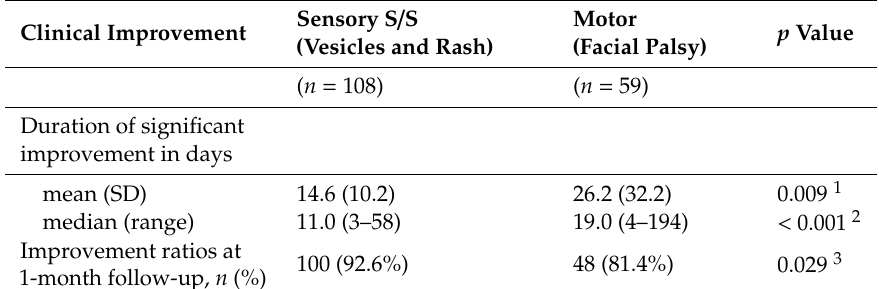
Table 4. Outcome of the cranial sensory and motor symptoms / signs in patients with herpes zoster infection.